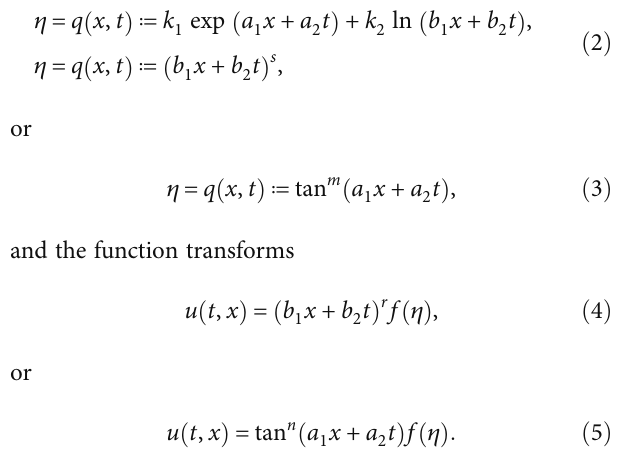
Figure 1: Flow chart of the power index